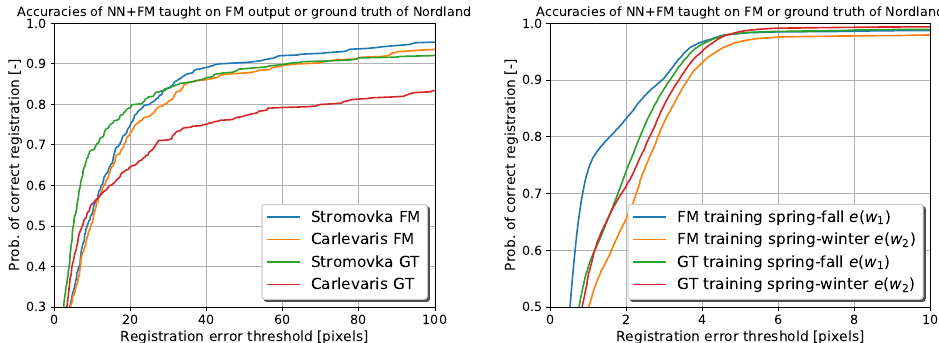
Figure 9. Probabilities of correct image registration on Nordland, Stromovka and Carlevaris datasets when using supervised and unsupervised